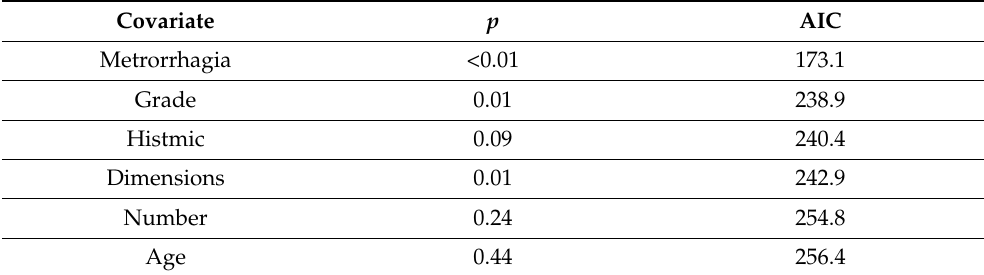
Table 3. The univariate analysis.